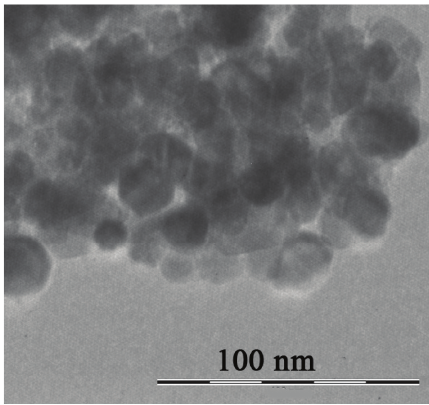
Figure 1: TEM image of as prepared nano SmBa 2 NbO 6 .